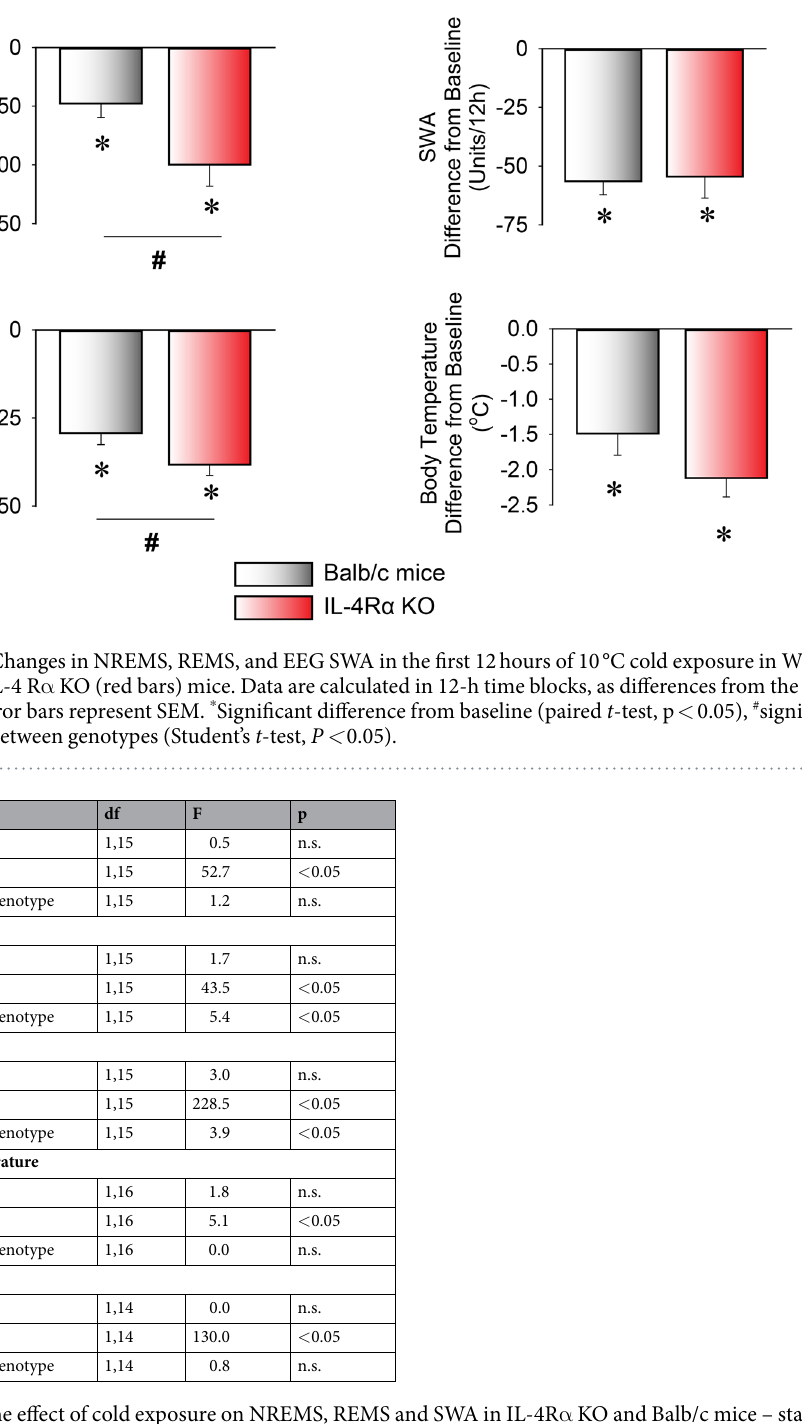
Table 3. The effect of cold exposure on NREMS, REMS and SWA in IL-4R α KO and Balb/c mice – statistical